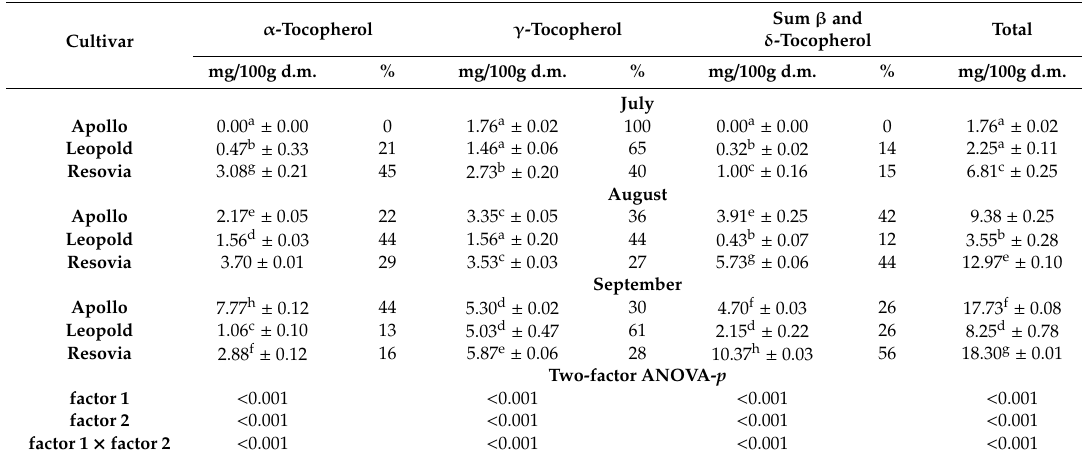
β and δ -Tocopherol Total